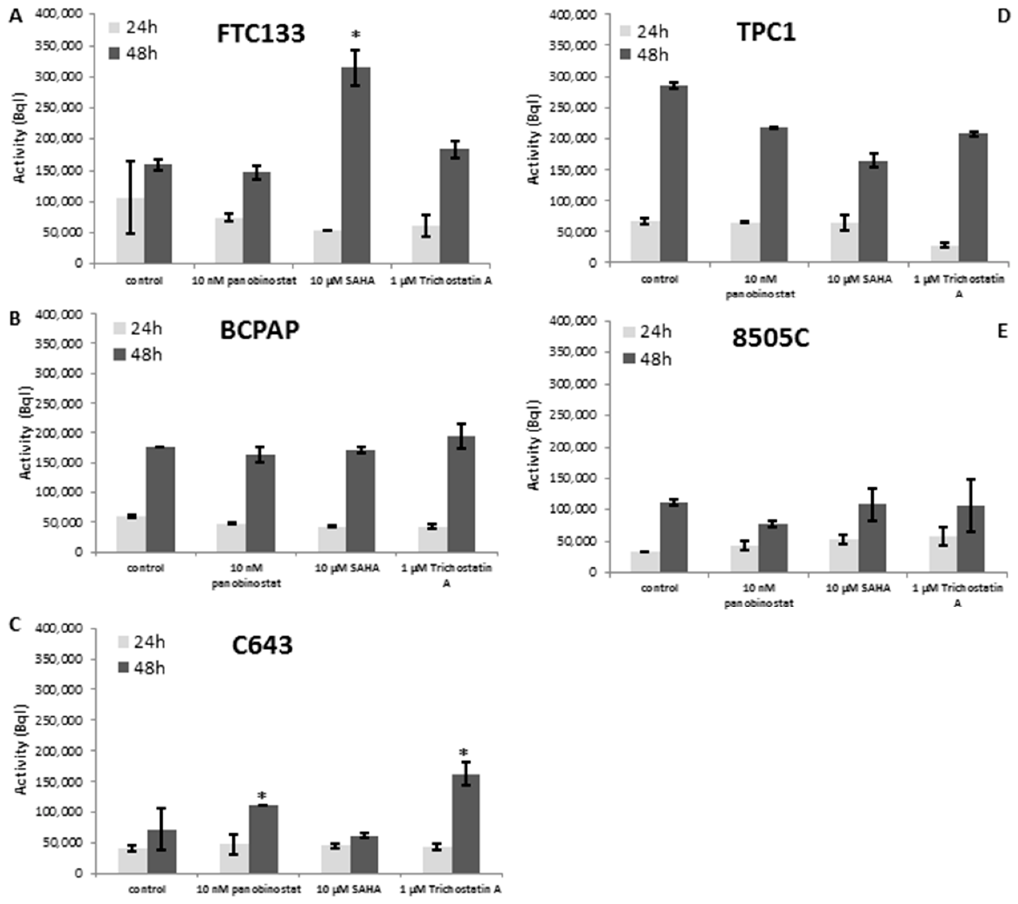
Figure 6. Radioiodine activity measurement after treatment with deacetylase inhibitors. FTC133 ( A ), BCPAP ( B ), C643 ( C ), TPC1 ( D ) and 8505C ( E ) cells were treated for 24 and 48 h with 10 nM